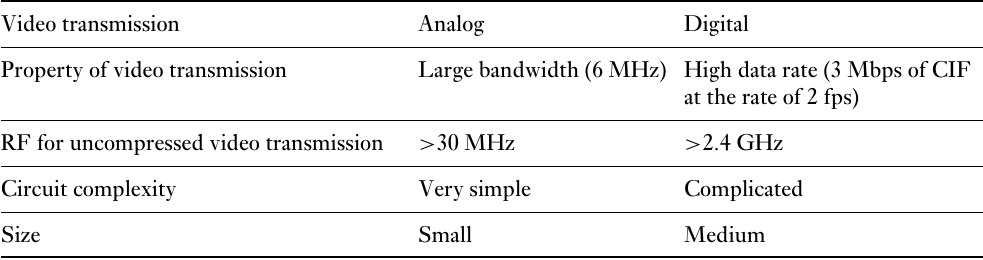
at the rate of 2 fps)